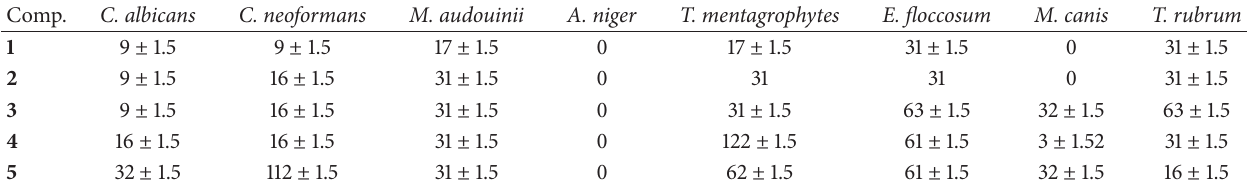
Table 6: MFCs ( 𝜇 g/mL) of 1–5 from C. sativum seeds against fungal strains.